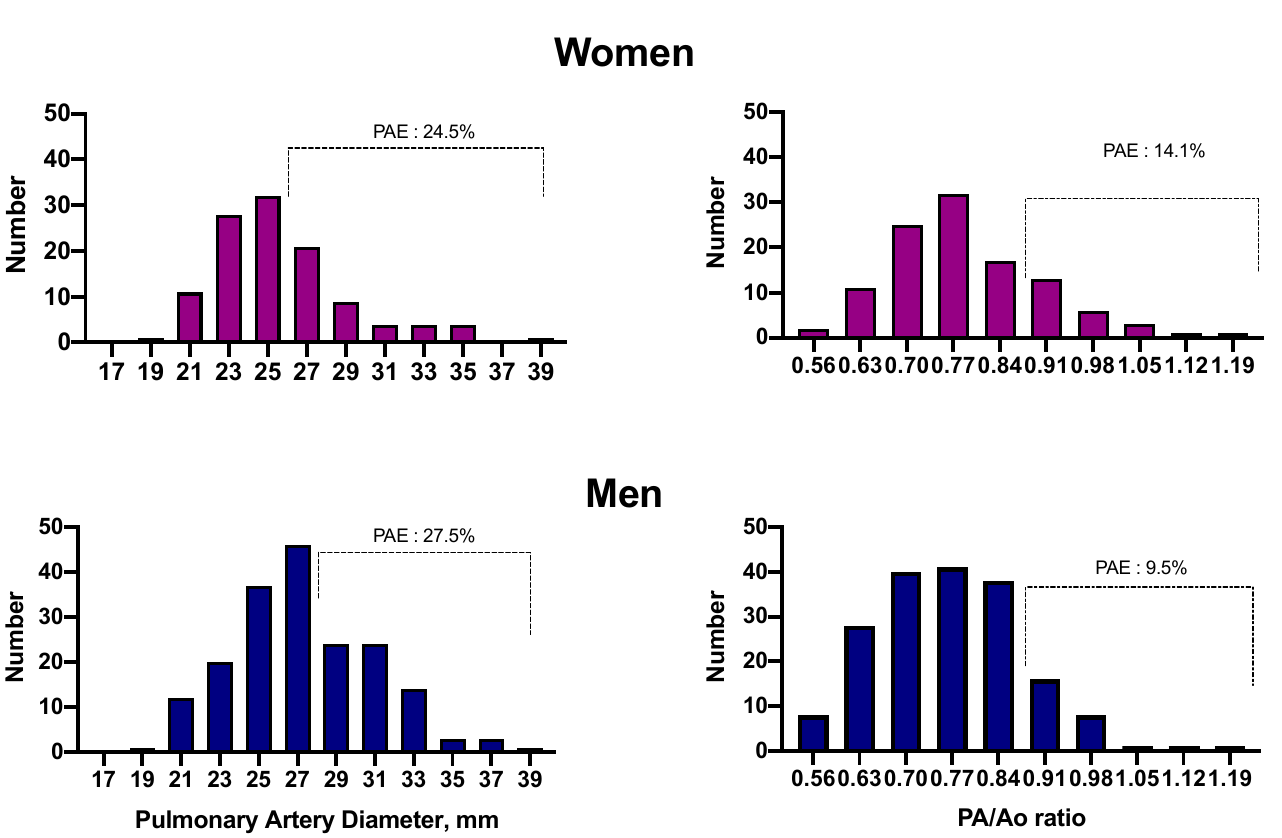
Figure 2. Distribution histogram for both women and men of the main pulmonary artery diameter (PAD) and ratio of PAD to ascending aorta diameter (PA/Ao ratio). Prevalent pulmonary artery enlargement (PAE) as defined by PAD and by PA/Ao ratio occurred in 24.1 and 15.4% of women and 29.1 and 9.3% of men, respectively.